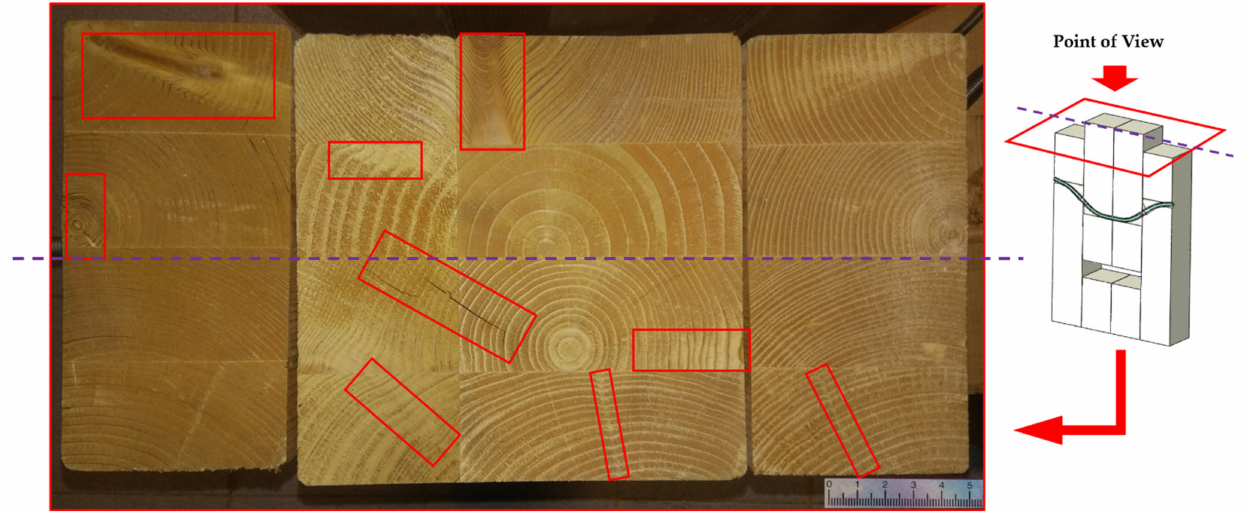
Figure 3. Configuration of timber (unpolished, top view), showing some heterogeneities (marked by red squares) and its plane of